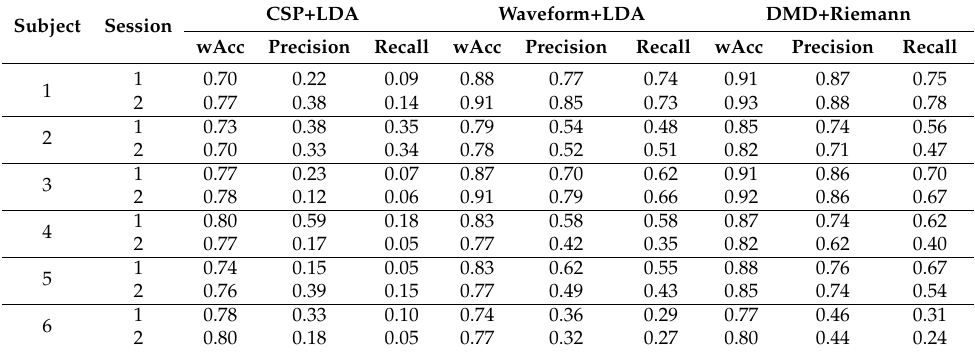
Table 1. Comparison of the classification performance of CSP, waveform and DMD+Riemann on the data of each session of each subject. (Average results of 10-fold cross-validation are